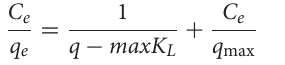
where q e (mg g − 1 ) is the amount of ions adsorbed per unit mass of ZnO at equilibrium; K L (L mg − 1 ) is the Langmuir constant related to the affinity of the binding sites; q max (mg g − 1 ) is